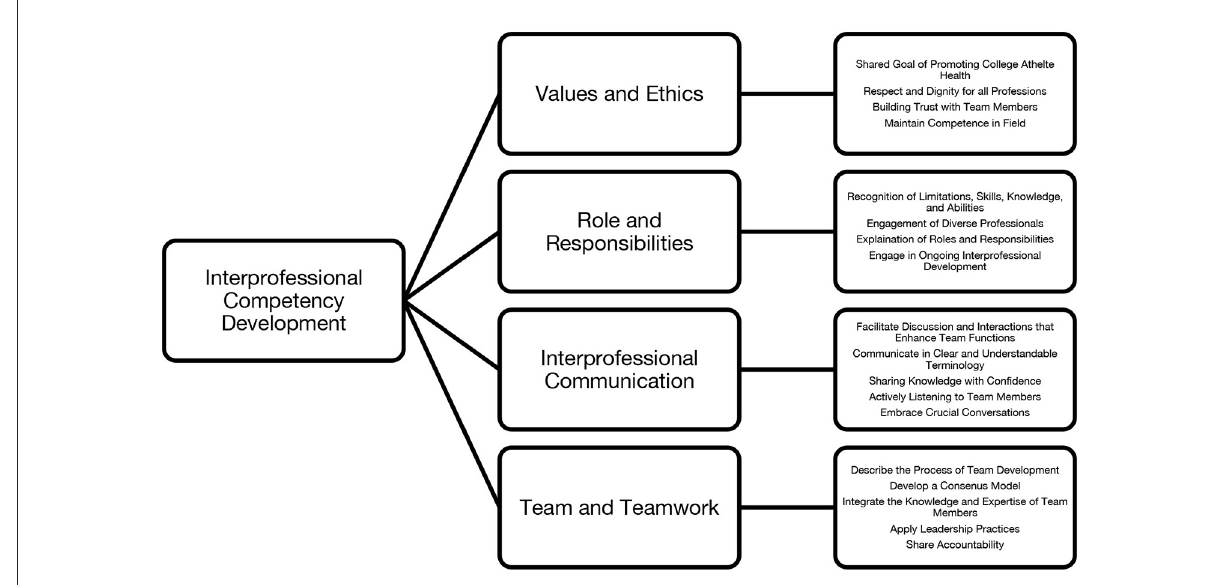
FIGURE1 Competency-based development of a college athlete integrated care team.